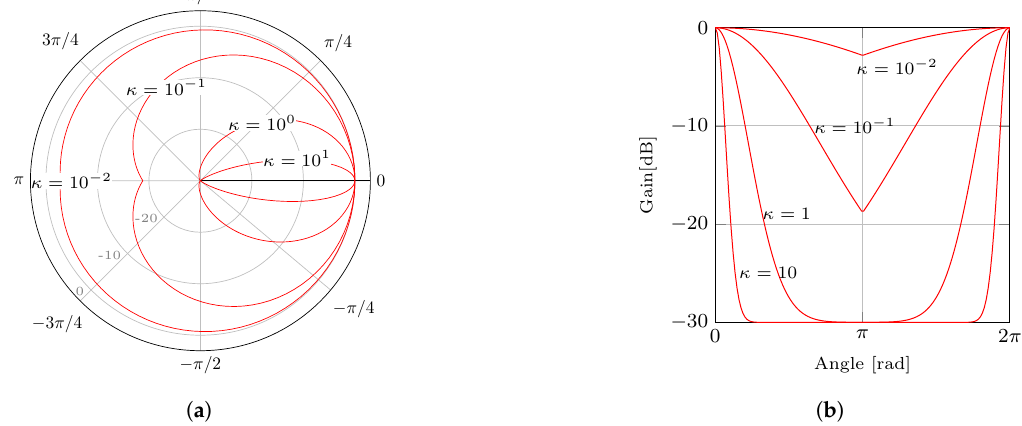
Figure 5. Antenna pattern for different values of κ . ( a ) Polar plot; ( b ) gain vs. angle